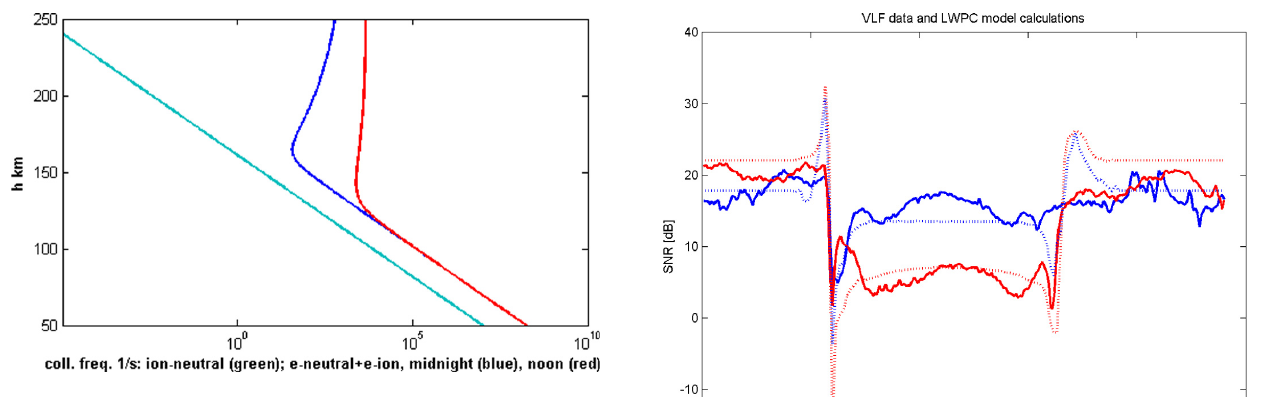
Fig. 7. Undisturbed collision frequency profiles. With these profiles (and those displayed in Fig. 6) modulated by the atmospheric waves (see text) the signal amplitudes in Fig. 9 have been computed.